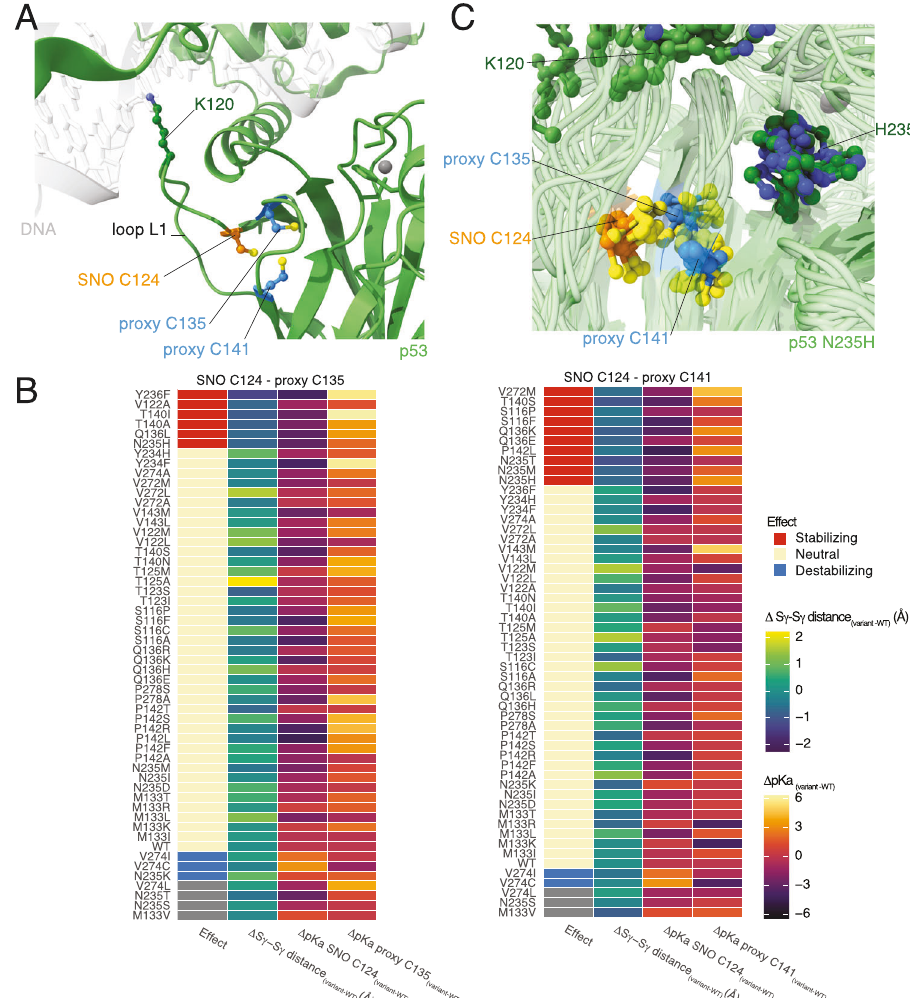
Fig. 8 Cancer variants in TP53 could modify the population-shift mechanism induced by S -nitrosylation. A The green cartoon shows the AlphaFold model of the tumor protein 53 (p53). We show, as a reference, the location of the DNA from the X-ray structure of the p53 tetramer (PDB entry 3KZ8) as a grey transparent cartoon. We used AlphaFill to include the missing zinc atom (grey sphere) in the DNA-binding domain of p53. The stick and ball representation highlight the S -nitrosylated site C124 (SNO, orange), proximal C135 and C141 (proxy, blue), and K120 (dark green), a key residue for interaction with DNA located in the DNA-binding loop L1. B We analyzed the coarse-grained models of the variants of p53 in the proximity of the SNO site and proximal cysteines and compared them to the wild-type (WT) p53. The heatmaps and proximal cysteines (third and fourth column, respectively). We then classi fi ed each variant ( fi rst column of the heatmaps) on its effects on the structural mechanisms of S -nitrosylation. We classi fi ed the variants as i) stabilizing (decreased pK a of the SNO site and shorter S γ -S